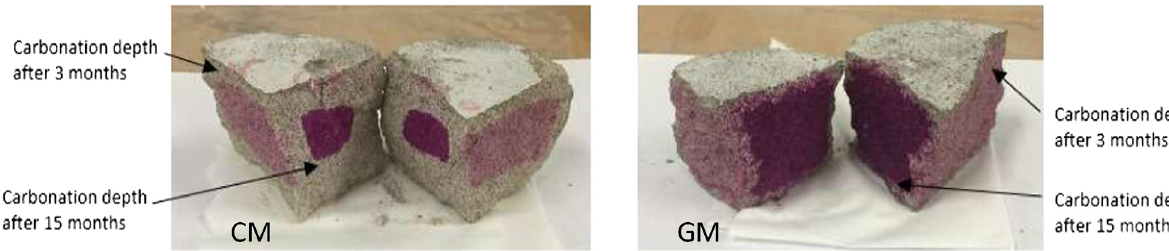
Figure 19: Images for cementitious mixes after carbonation [ 122 ]